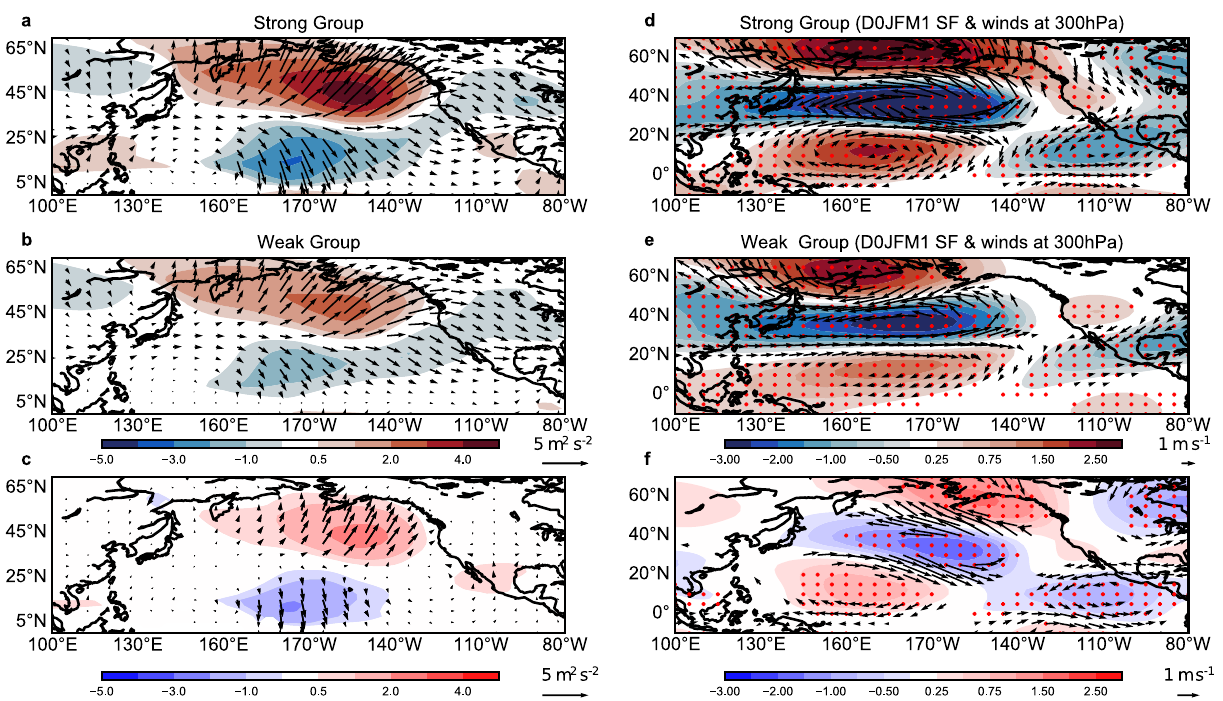
Fig. 3 Composite of D0JFM1 WAF (left) and 300-hPa wind and SF anomalies (right) for the strong and weak MWAF groups as well as the differences between groups. a The 300-hPa WAF for NPO events in the strong MWAF group. b The 300-hPa WAF for NPO events in the weak MWAF group. c The difference between the strong and weak MWAF groups. d , e Composite difference of D0JFM1 300-hPa wind (unit: m/s) and SF (unit: 10 6 m 2 s − 1 ) anomalies between positive and negative NPO events for the strong and weak MWAF groups, respectively. f The difference of 300-hPa wind and SF anomalies between the two groups. The shading in the left panel represents the MWAF, whereas it is the SF in the right panel. The vectors are shown only with the zonal wind above 90% con fi dence level, and the dots represent the areas of SF above 90% con fi dence level.